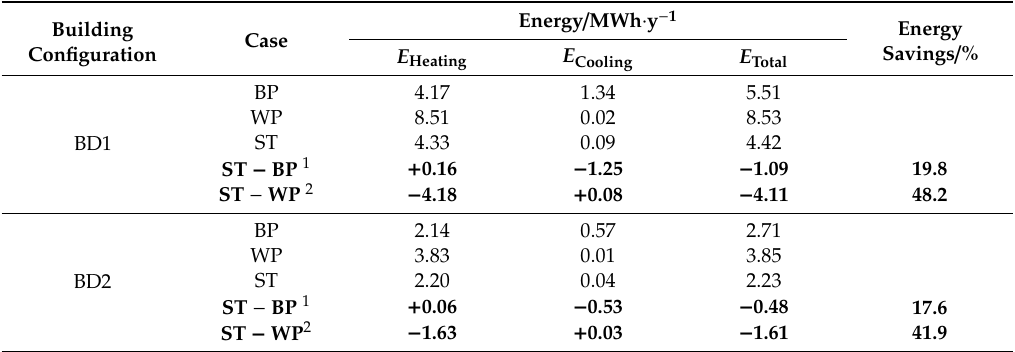
Table 4. Final energy demand for heating ( E Heating ), and cooling ( E Cooling ), total final energy demand ( E Total ), and energy savings over the year, for a building painted with an optimized thermochromic step transition paint (ST), located in Porto,